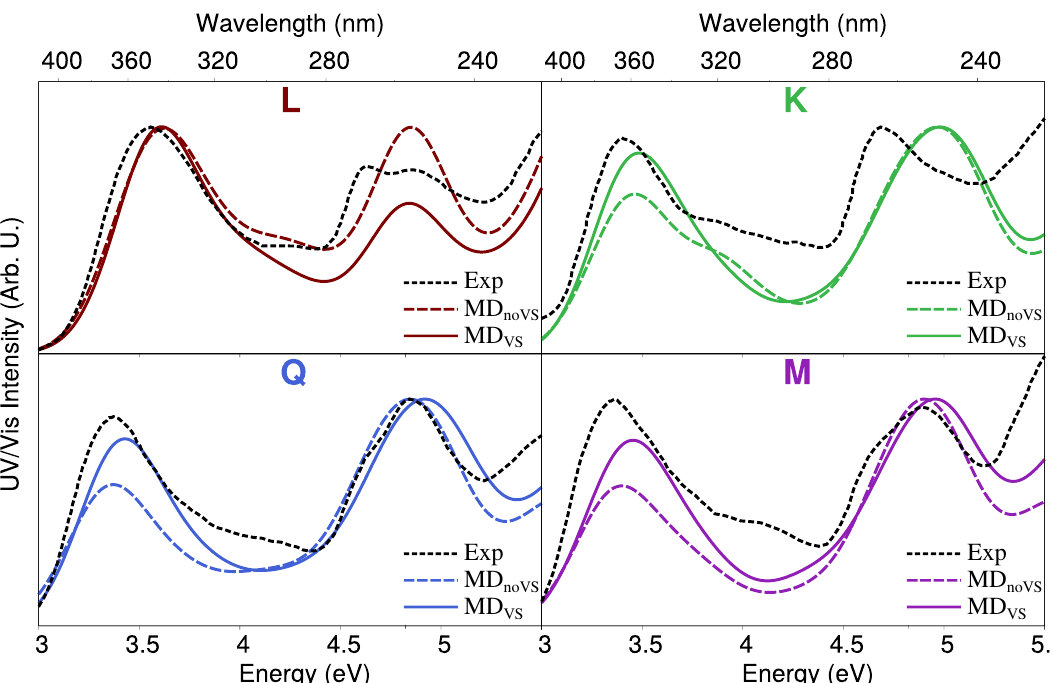
Figure 9. Computed absorption spectra of each studied flavonoid in aqueous solution obtained by using QM/FQ coupled with both MD VS and MD noVS . Experimental UV/Vis spectra reproduced from Refs. [28,67] are also